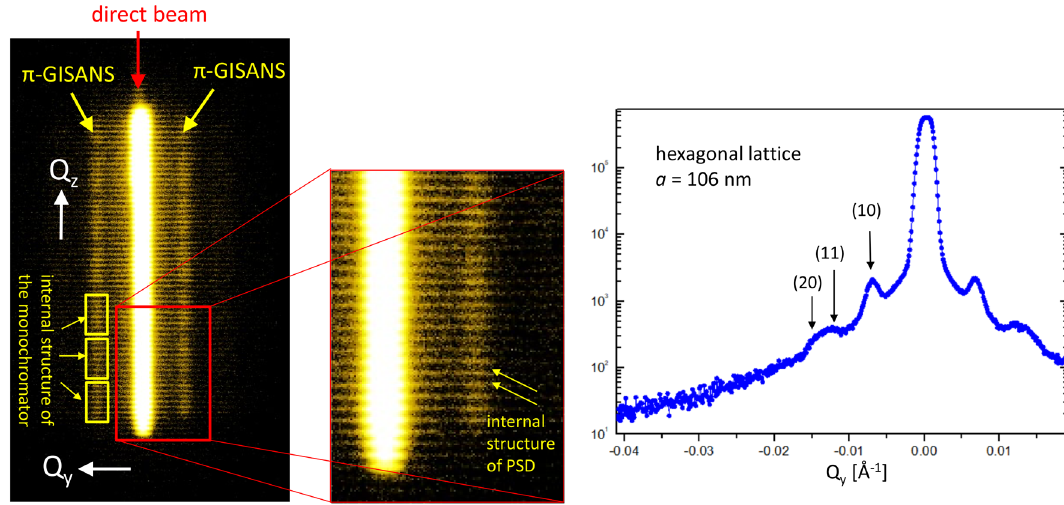
Figure 3. π-GISANS data taken on Super ADAM with a sample of a porous aluminum oxide film with the pores filled with iron. The left panel depicts the image on the PSD of Super ADAM with the individual monochromator crystals well visible. The center panel depicts a zoom into the detector image to highlight the internal structure of the wire detector. The panel on the right hand side depicts the vertically integrated data revealing Bragg scattering from the iron arranged in a hexagonal